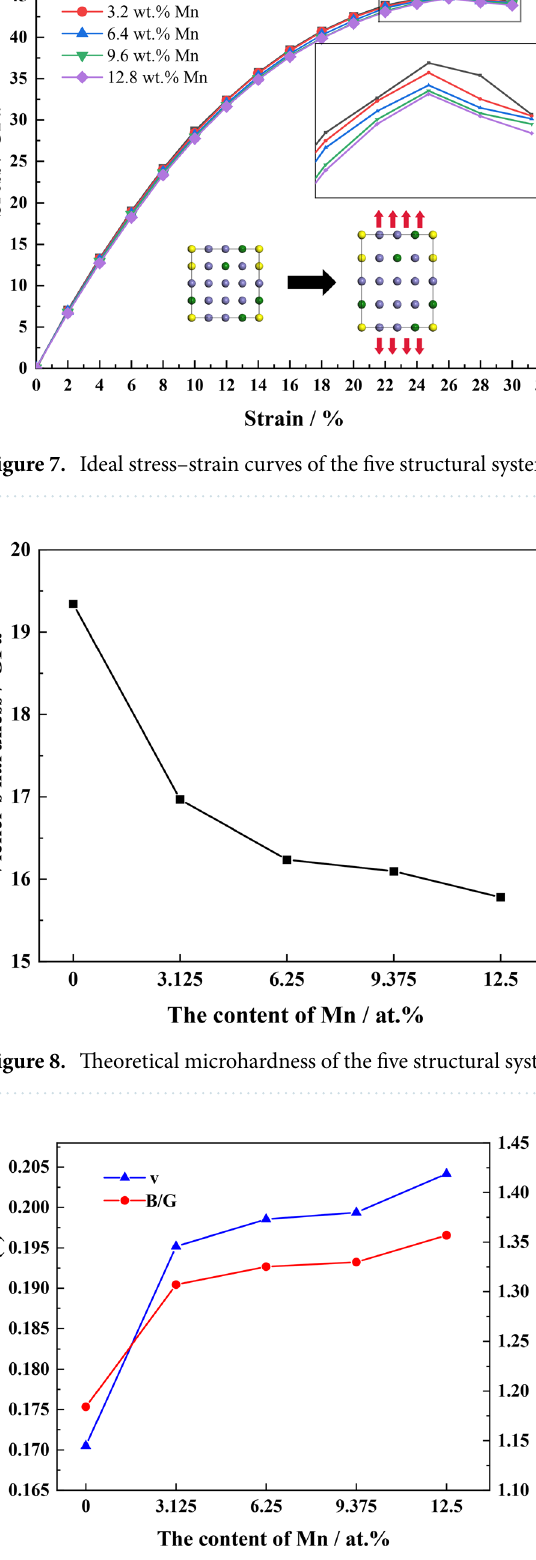
Figure 9. Poisson’s ratio (ν) and Pratt’s modulus ratio B/G for the five structural